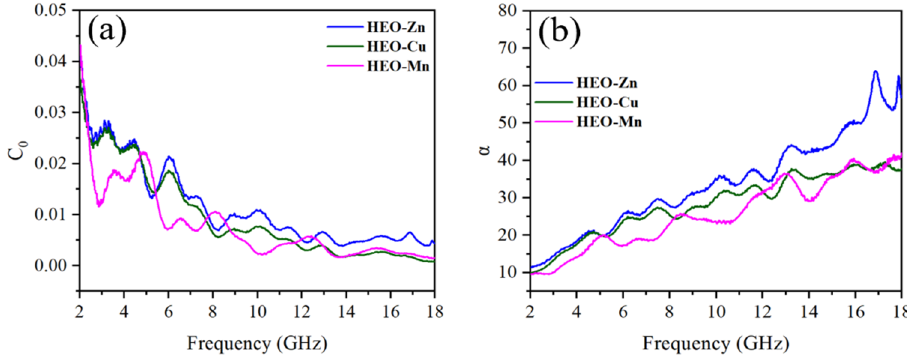
Figure 10. The relationship of ( a ) C 0 and ( b ) α with frequency of HEO − Zn, HEO − Cu, and HEO − Mn. The relevant EM wave absorption mechanism of HEO-Cu ferrite is shown in Figure